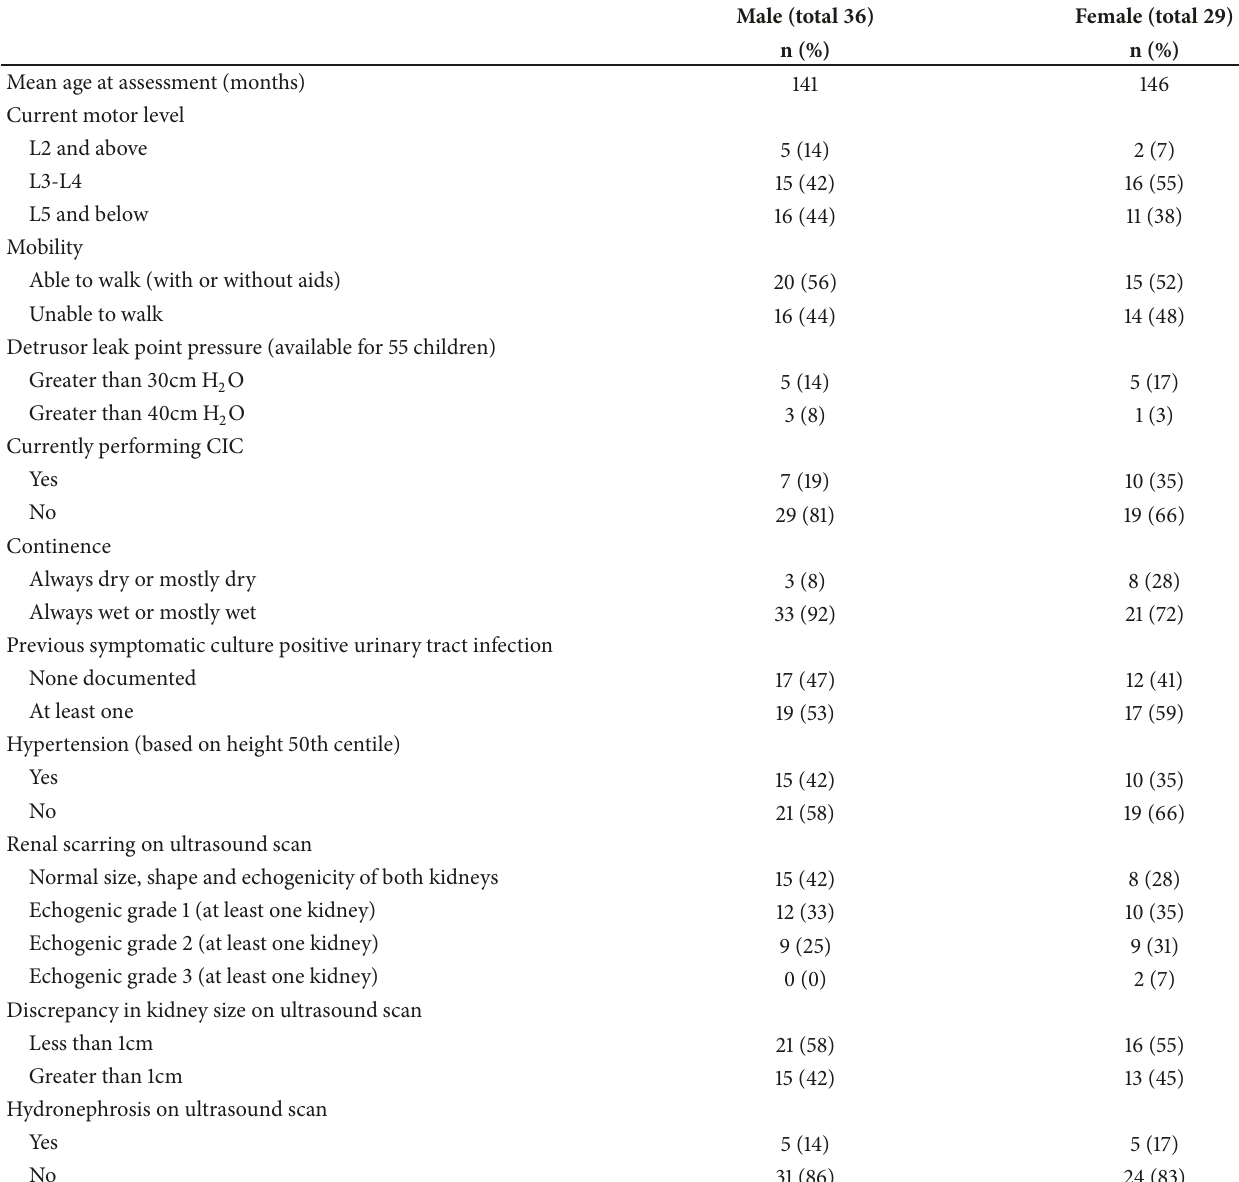
Table 1: Patient